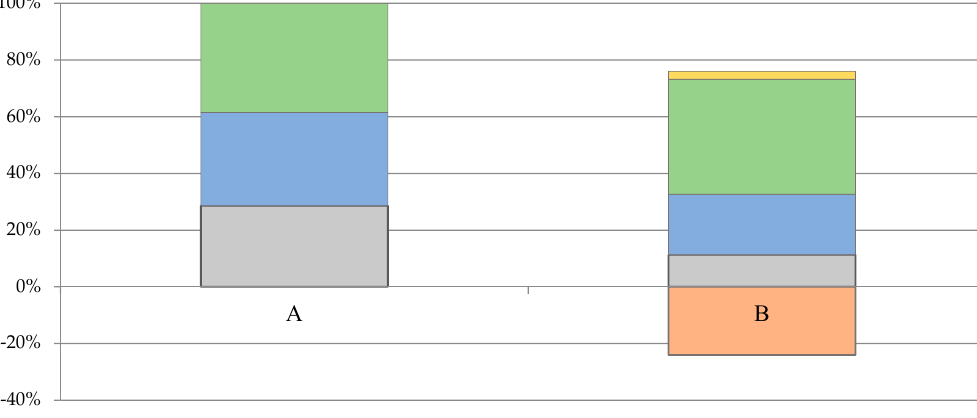
Figure 5. Structure of Levelized Cost of Electricity (LCOE) of the analysed agricultural biogas plants.